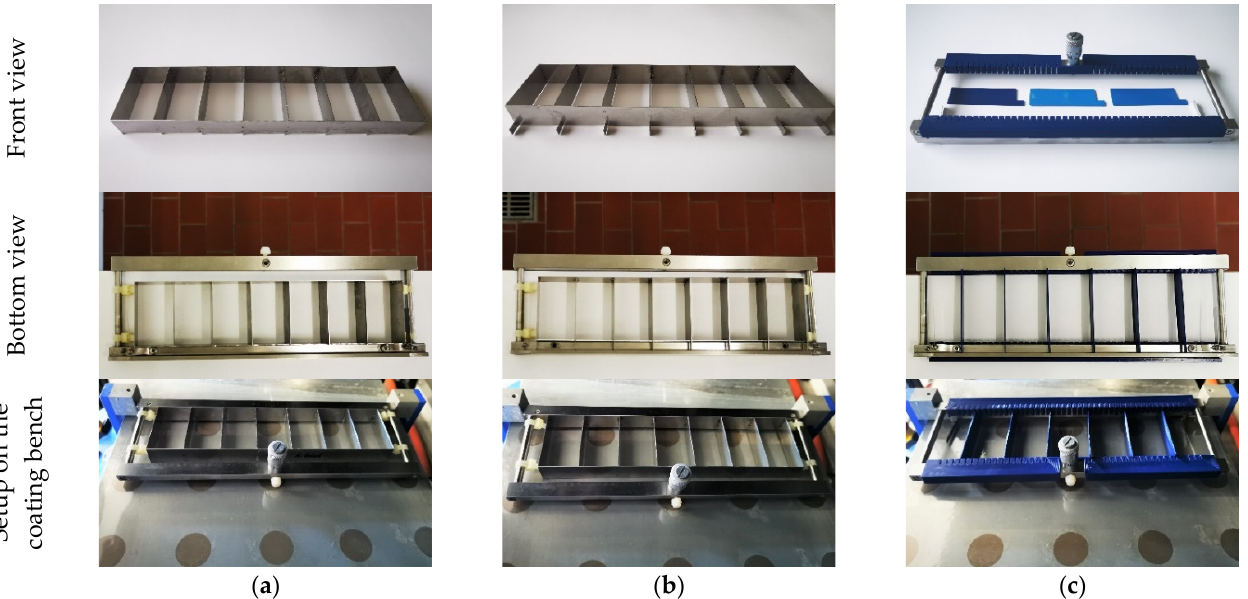
Figure 2. Comparison of the insert types in the front and bottom views and installed on the coating bench: ( a ) precursor steel model, ( b ) optimized steel model and ( c ) 3D-printed model.